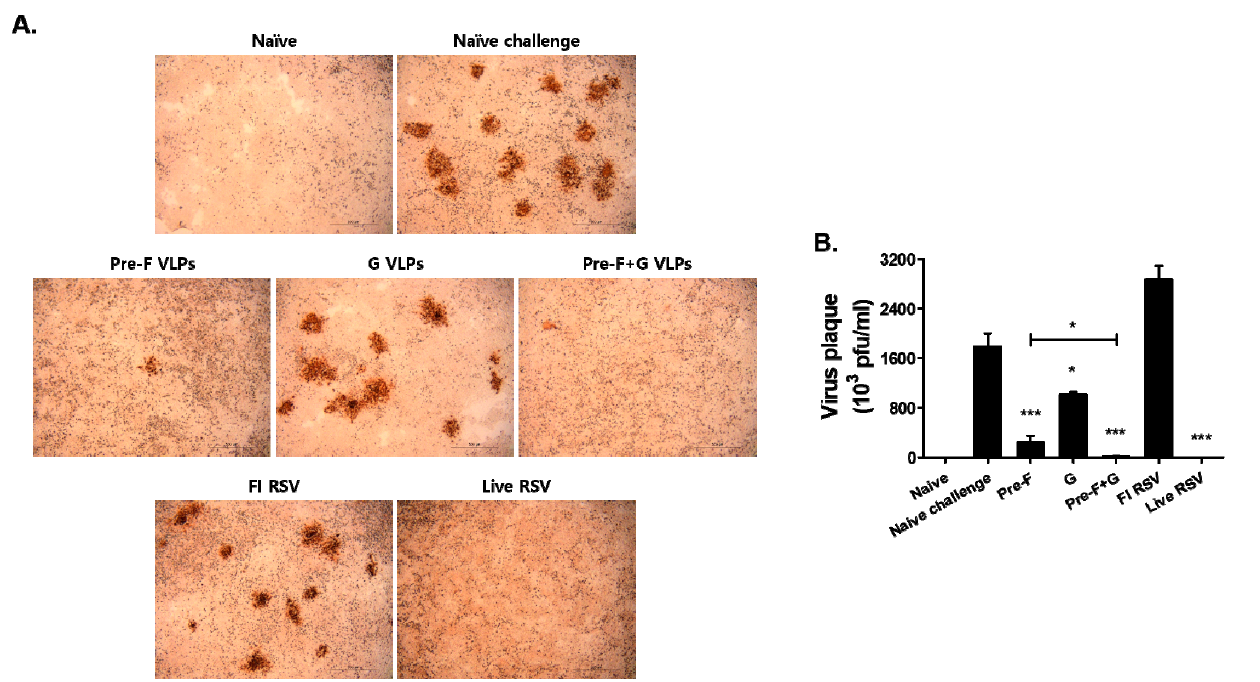
Figure 7. Lung viral titer after RSV A2 infection. Lung viral titers were determined individually (n = 6) from the lung homogenate. Lung tissues were collected from individual mice 5 days after RSV infection. To confirm the viral plaque formation, DAB substrate was used (( A ), scale bar, 500 µm). VLPs immunized mice showed significantly lower levels of viral titers than naïve challenged mice (( B ), * p < 0.05, *** p < 0.001).